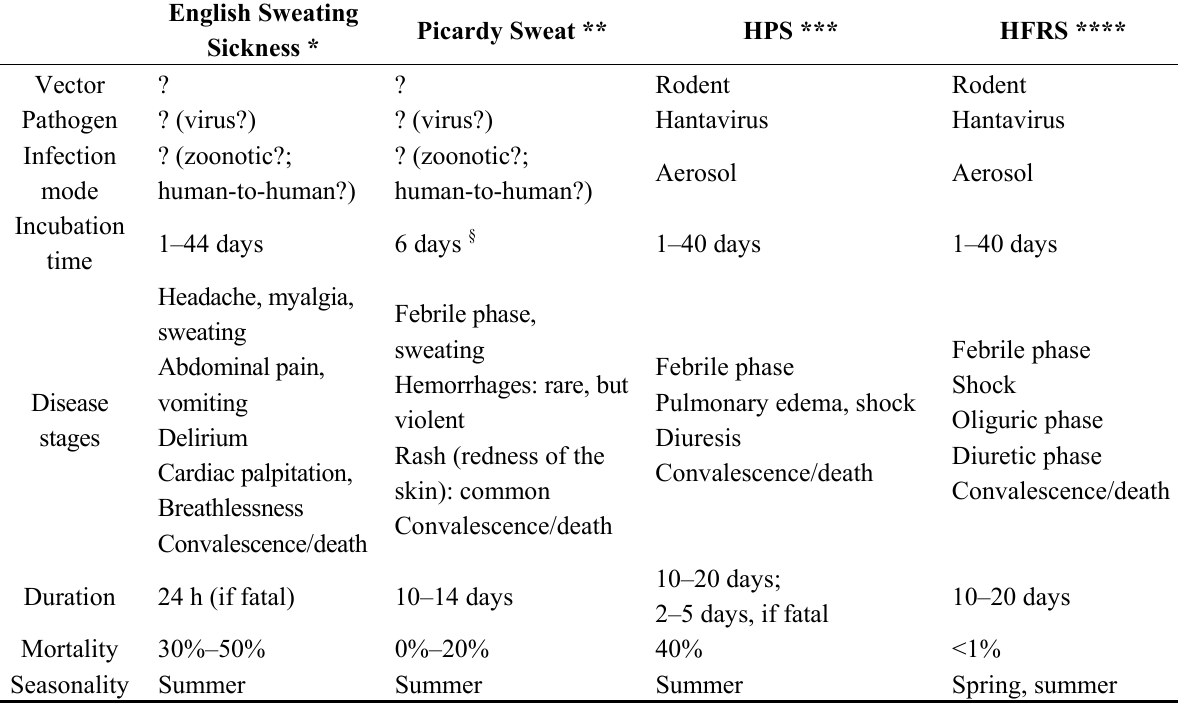
Table 1. Comparison of the English sweating sickness, the Picardy sweat, HPS and